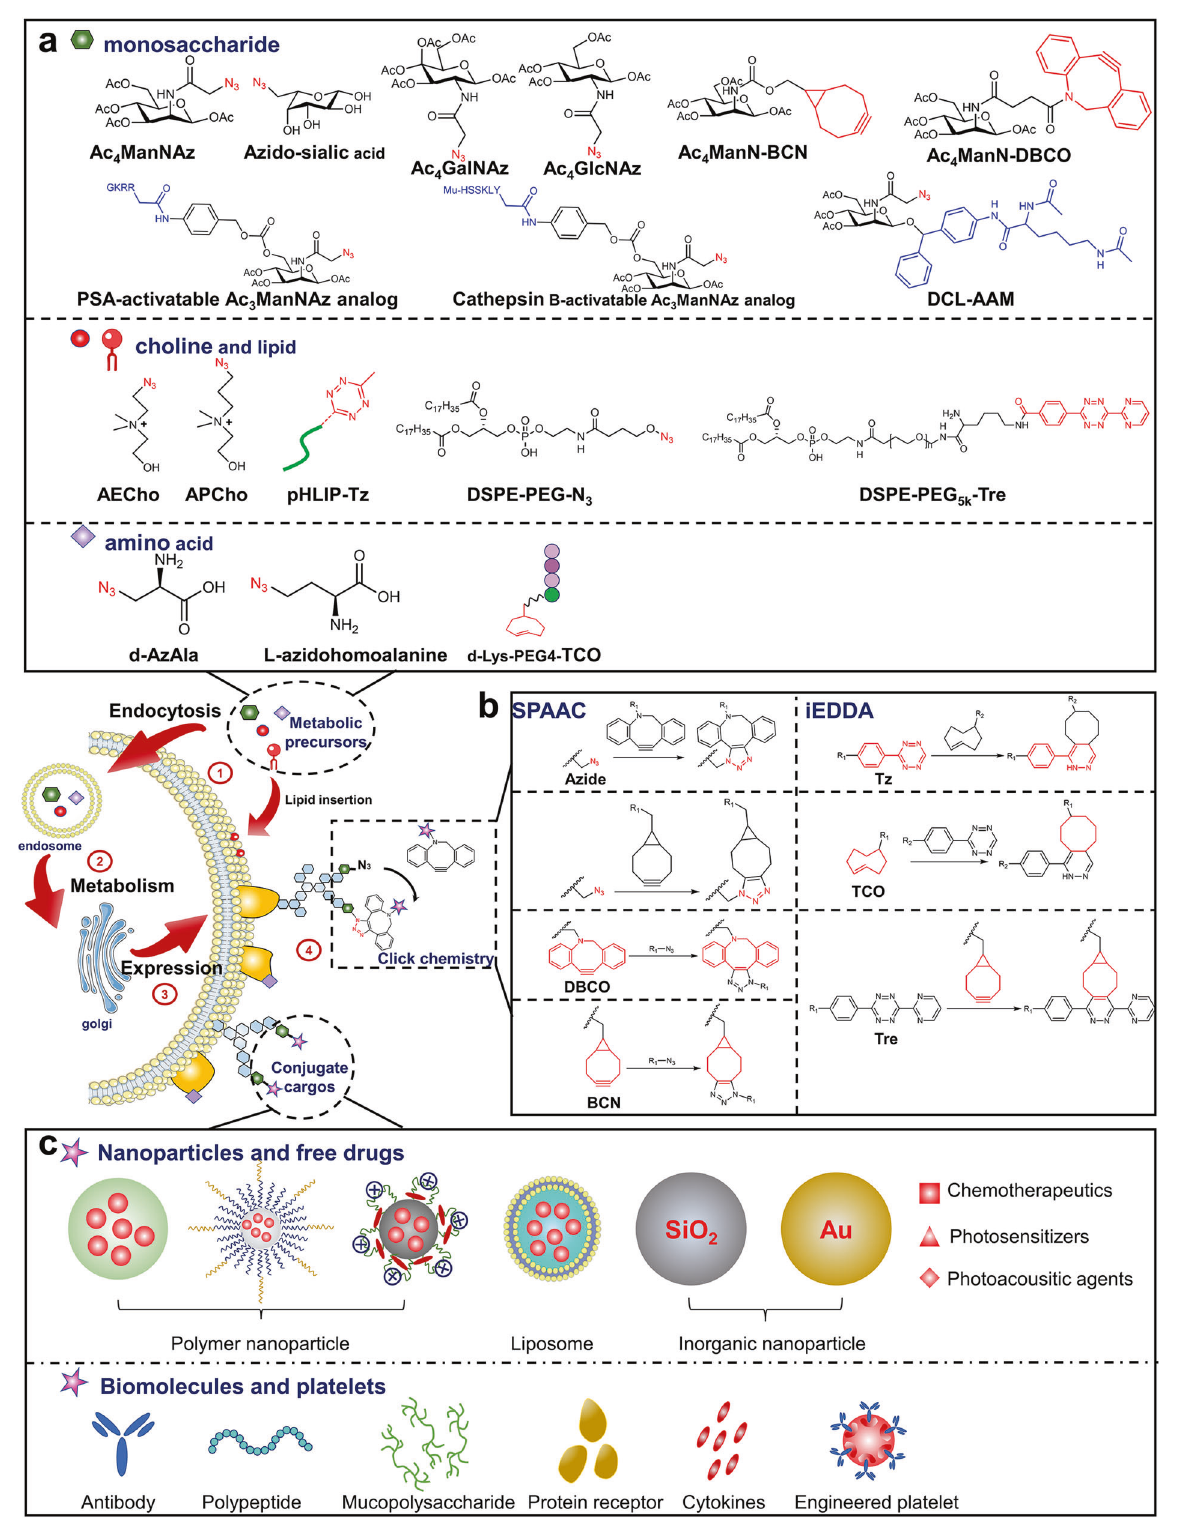
Fig. 1 Bioorthogonal metabolic labeling of living cells. First, metabolic precursors are endocytosed by cells. Second, precursors are involved in cellular metabolism. Third, bioorthogonal groups are displayed on the cell surface. Finally, cargos are conjugated to the cell through a click reaction. a Metabolic precursors with bioorthogonal groups. Unnatural sugars bind to cell surface glycans through the glucose metabolic pathway. Lipid precursors are embedded in cell membranes through phospholipid synthesis pathways or lipid insertion. Functionalized amino acids bind to membrane proteins through protein synthesis pathways. b SPAAC and iEDDA are used for targeted delivery and developing DDSs. c Conjugate cargos that bind to cell membranes via bioorthogonal